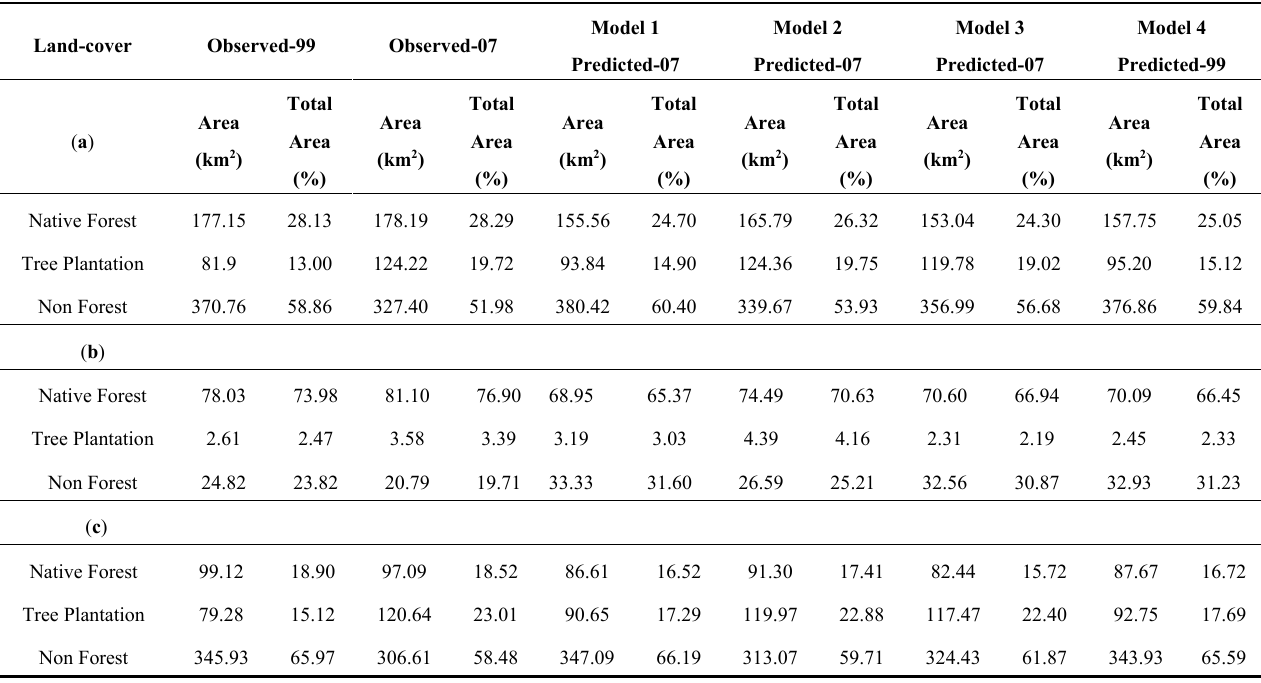
Table 4. Observed and predicted land-covers of 2007 and 1999 in BNP and it surroundings. ( a ) Observed and predicted land-covers BNP and its Surroundings (Buffer). ( b ) Observed and predicted land-covers BNP ( c ) Observed and predicted land-covers of the Buffer